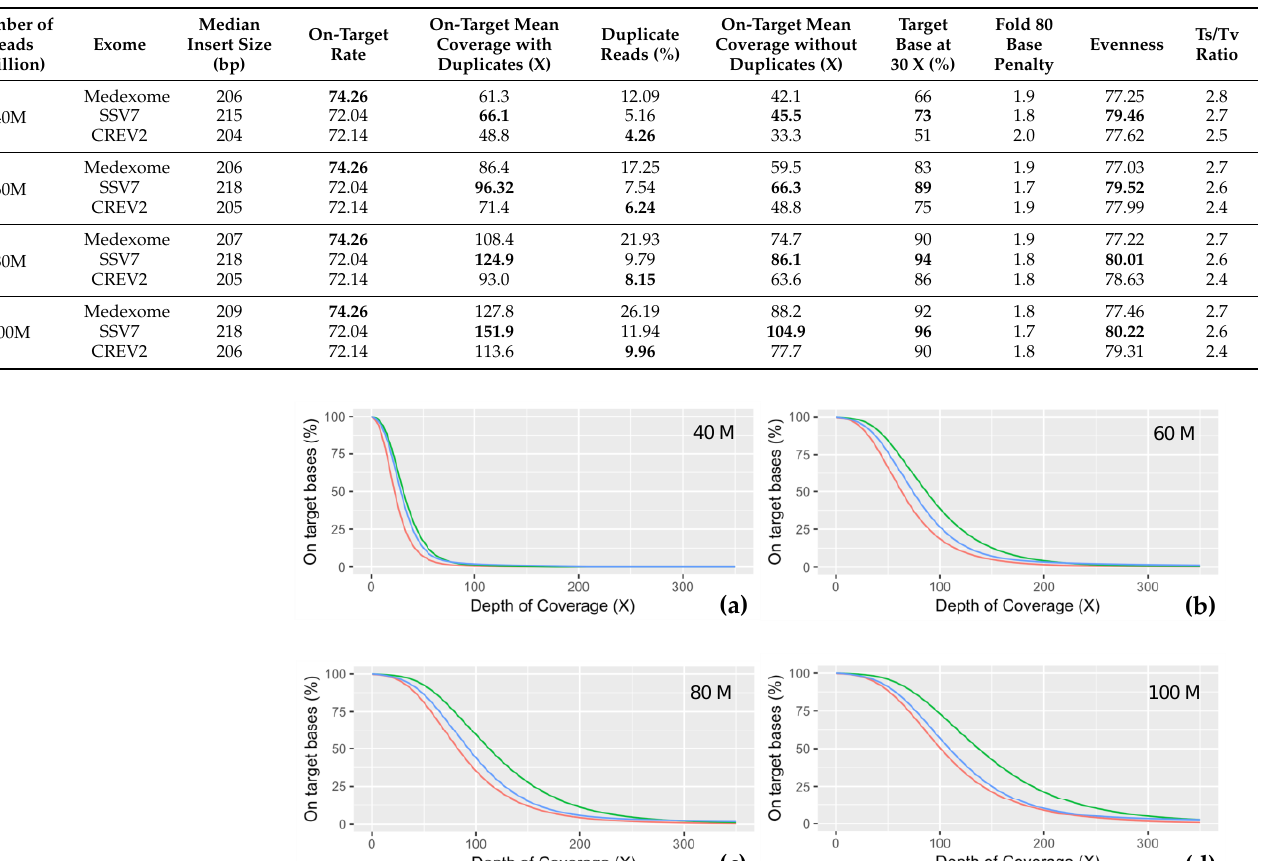
Table 2. Sample sequencing data quality obtained for the three ES kits. The best performances are shown in bold.